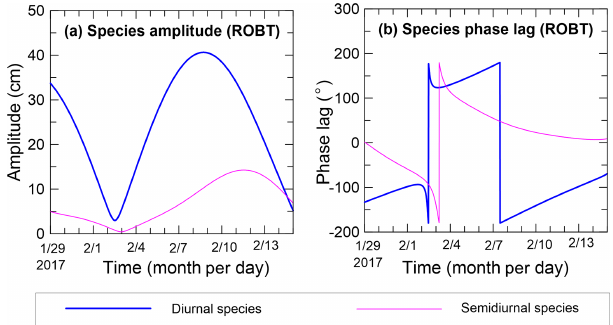
Figure 3. Modulated tidal (a) species amplitudes and (b) phase lags for the diurnal and semidiurnal tidal species, calculated from ROBT tidal prediction data (29 January to 14 February 2017), using Eqs. (A1) and (A3) in Appendix A. Throughout the figures, dates are displayed in mm/dd format.